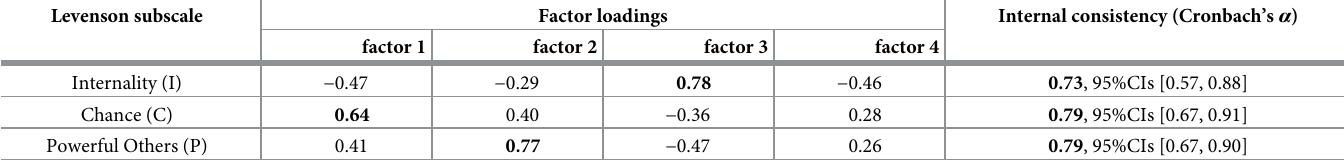
Table 1. Analysis of LoC subscales. In this table we report various measures to gain insight into the structure and consistency of the LoC subscales. We performed a vari- max-rotated factor analysis on the single items to obtain the factor structure of the questionnaire responses. We used four components ( p χ 2 = 0.1). The cumulative variance explained by the first three factors was 35%, in line with the values found in literature (see, e.g. [23]). We correlated scores (i.e. the projections of the questionnaire responses along the factors) with the I,P and C scales to see whether these were reflected (coefficients significant post false discovery correction for multiple comparisons are in bold). The results replicate well those found in literature, as they suggest that the first three factors largely reflect the 3 dimensions individuated by Levenson (Leven- son 1974). Although the fourth factor appears to individuate a further, non-specific external component (as it is anticorrelated with I-scores, and weakly positively corre- lated with C and P scores) none of its correlation coefficients reach significance, which suggests that the variability that this dimension captures is not enough to warrant adding a further dimension. Finally, we report internal consistency measures, along with 95% confidence intervals, in the last